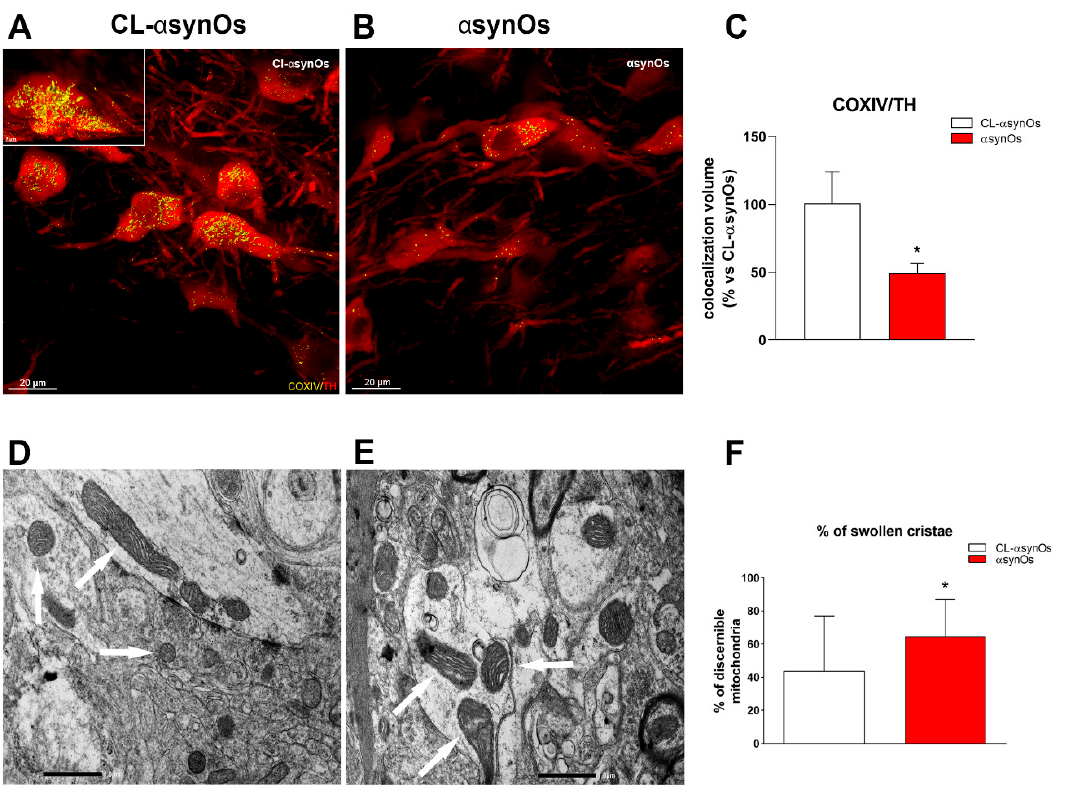
Figure 8. H- α SynOs induced early mitochondrial damage in the SNpc. Representative confocal images showing COX IV staining (yellow) in TH-positive cells (red) from the SNpc, contralateral ( A ) and ipsilateral ( B ) to H- α SynOs infusion, one month post infusion. Total volume occupied by COX IV in TH-positive cells ( C ); values are expressed as a percentage of contralateral (CL) side and represent the mean ± SEM. Representative images of mitochondria (10,000X, scale bar 1.0 µ m) acquired with TEM from the SNpc, contralateral ( D ) and ipsilateral ( E ) to H- α SynOs infusion, one month post infusion. Arrows indicate mitochondria with normal cristae in A, and with swollen cristae in B; percentage of swollen cristae ( F ). * p < 0.01 vs. CL-H- α SynOs by t-test ( n = 4 per group).